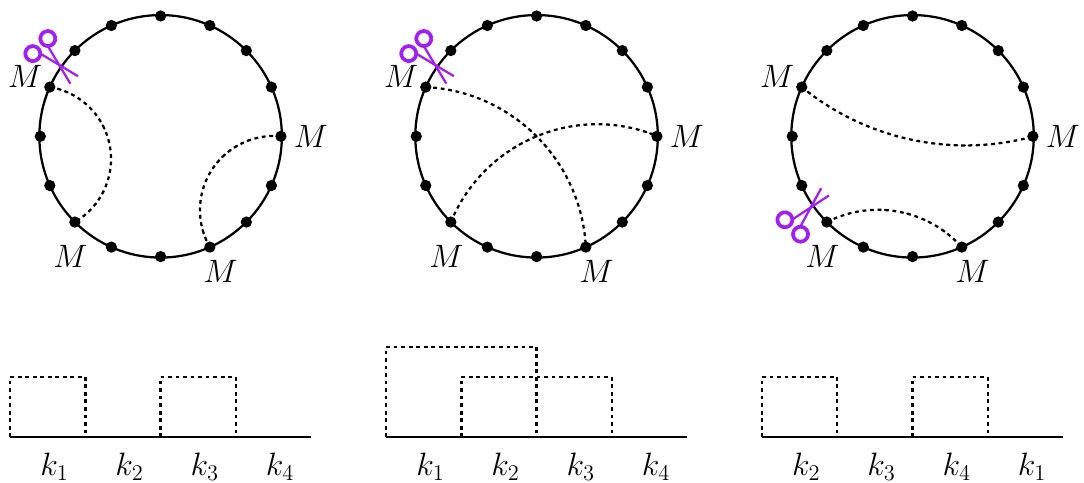
Figure 11. The three possible contractions in a 4-point function. Only the M -nodes are shown. By choosing appropriate cuts, we get that the (cid:12)rst and third contractions are the same.